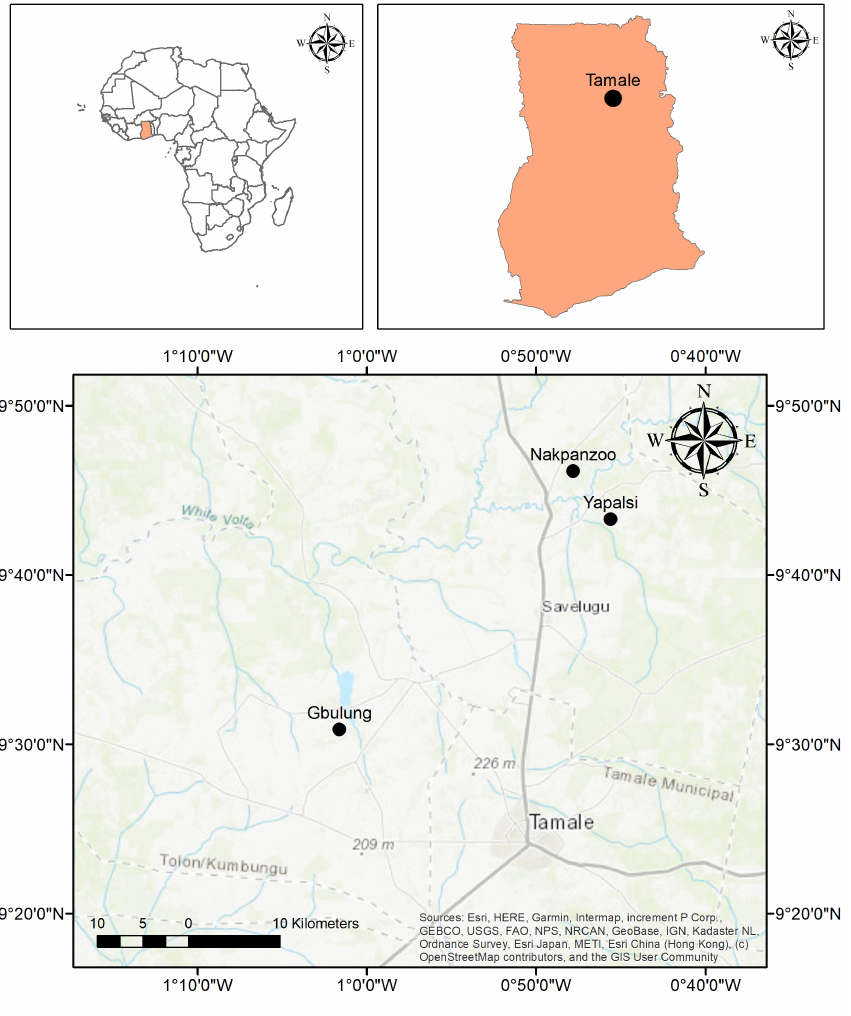
Figure 1. Map showing locations of the study area in northern Ghana. Gbulung community is located in the Kumbungu district, northwest of Tamale, the regional capital, while Nakpanzoo and Yapalsi communities are located at the Savelugu district north of the